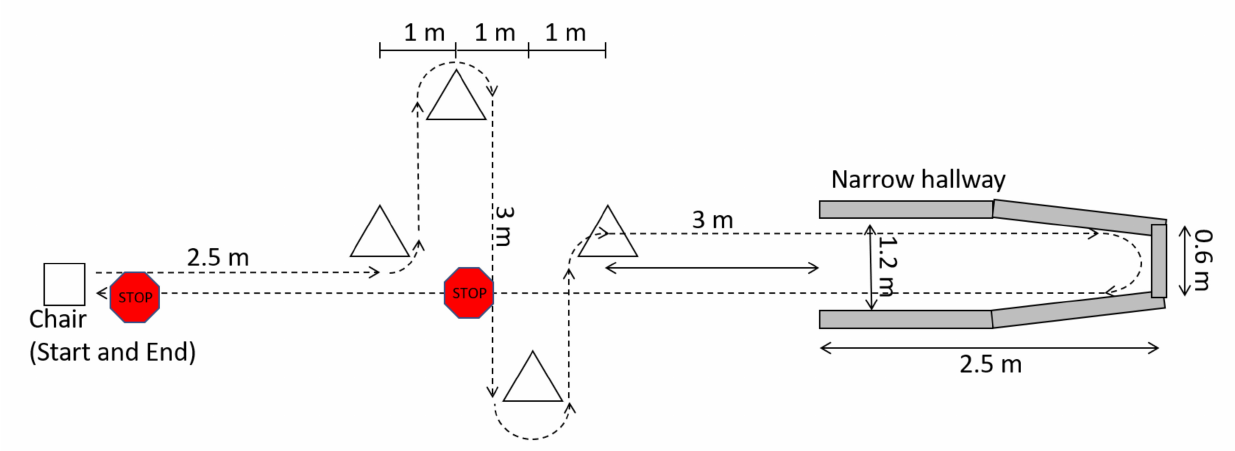
Figure 1. Experiment walking